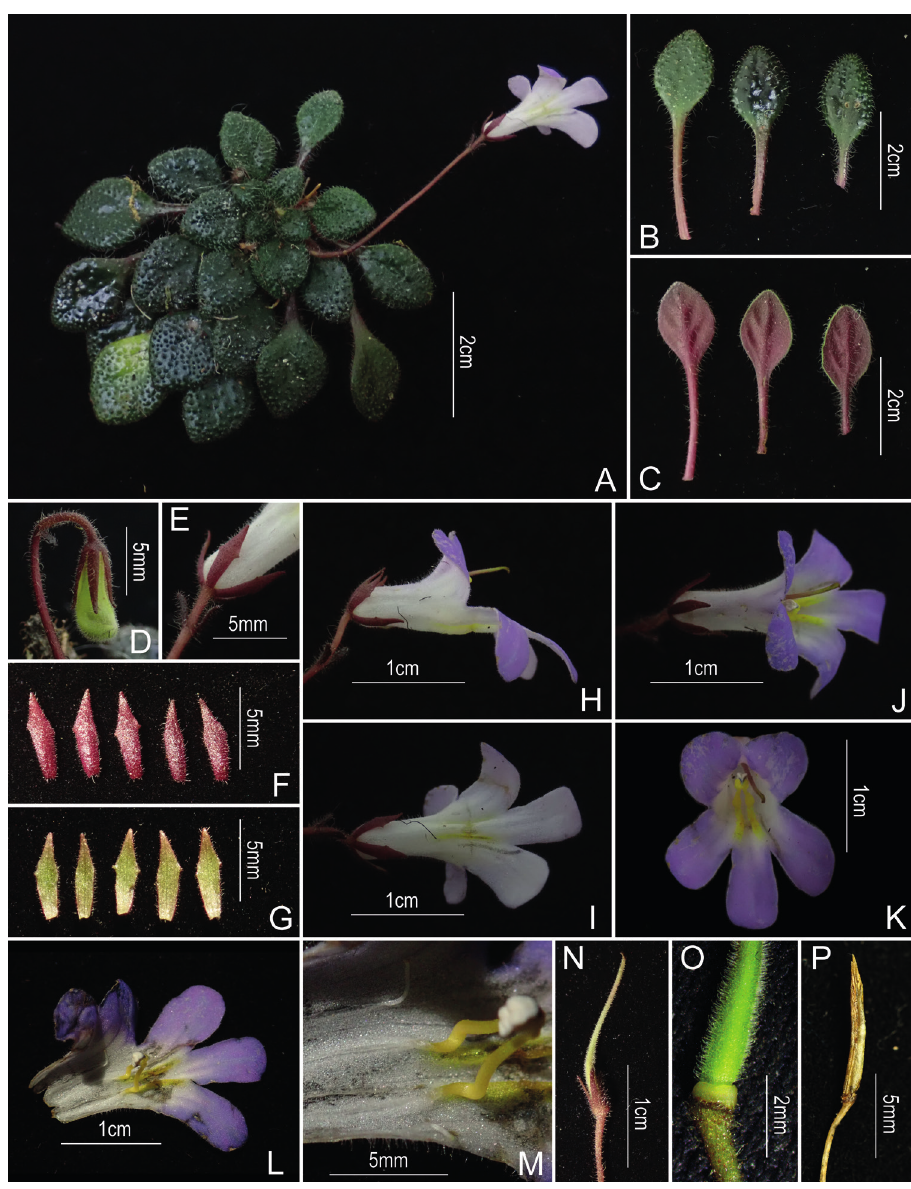
Figure 1. Primulina nana sp. nov. A habit B adaxial side of leaves C abaxial side of leaves D alabastrum E bracts and calyx F abaxial side of calyx lobes G adaxial side of calyx lobes H lateral view of a flower I ventral view of a flower J top view of a flower K front view of a flower s howing the internal structure L opened corolla M stamens and staminodes N pistil with calyx O disc and ovary P capsule. Photographs by Chi